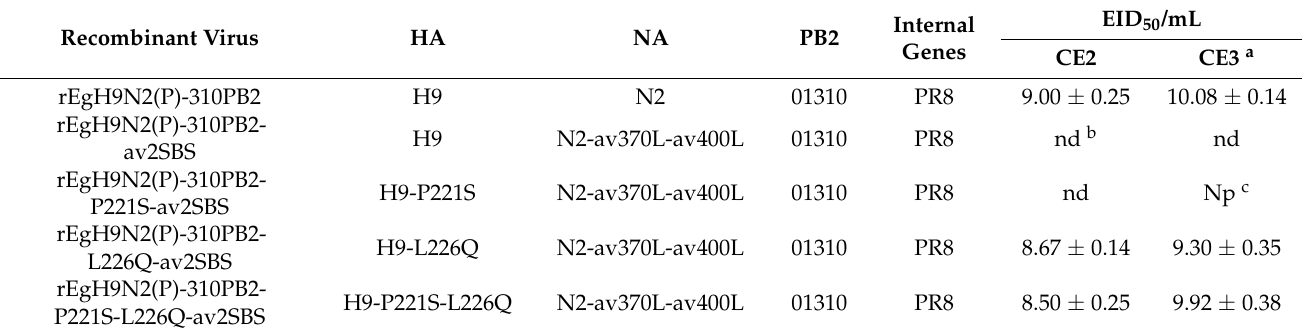
Figure 7. The E627V mutation of PB2 is a key MPM of Egyptian H9N2 AIVs. Based on the plasmid encoding PB2 of 01310 with I66M, I109V, and I133V mutations (MVV), single (E627V) and multiple (I292T, K526R, G590C, E627V, and S714G) mutations acquired by Egypt H9N2 viruses were introduced. Each PB2 plasmid was cotransfected with plasmids for PB1, PA, NP of PR8, firefly luciferase, and pRL-TK plasmid into 293T cells. Firefly luciferase activity was normalized to Renilla luciferase activity and compared with the PB2 of PR8. The average and standard deviation of three independent replicates are shown. * Significantly different from the PB2 gene of 01310, ** Significantly different with others ( p < 0.05). Table 4. PR8-derived recombinant Egyptian H9N2 strains with the 01310 PB2 gene and viral titers in